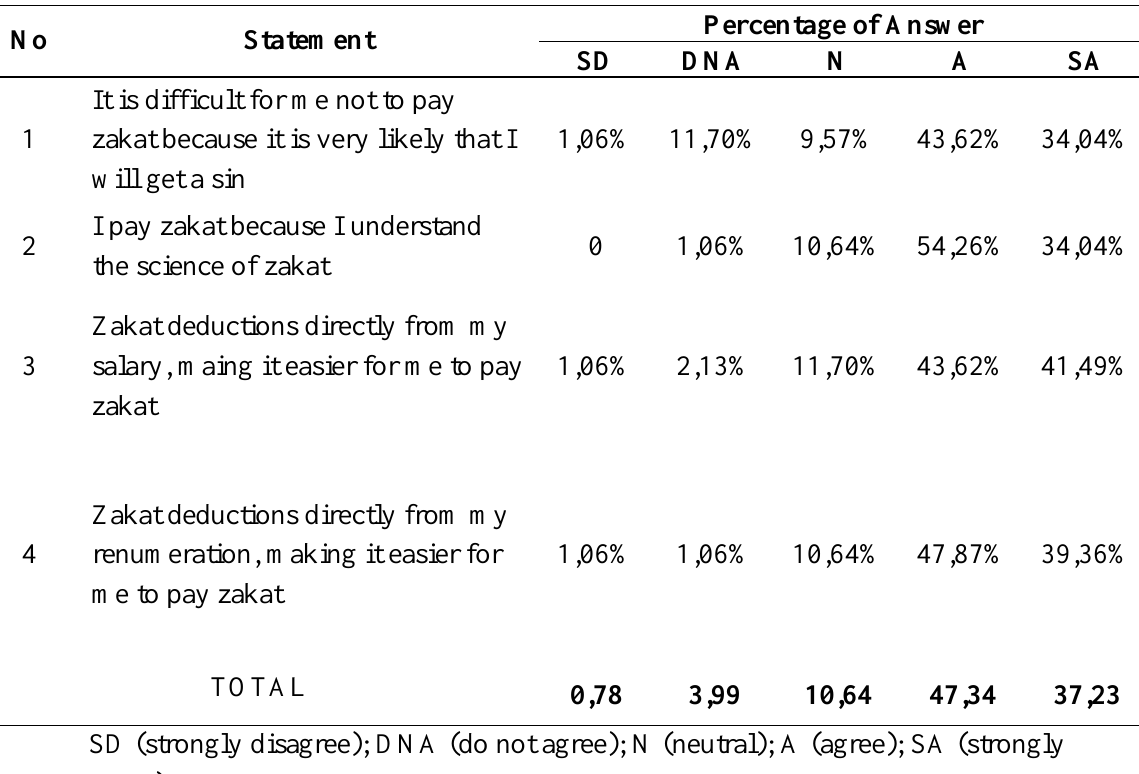
Table 5: Description of Behavioral Control variables